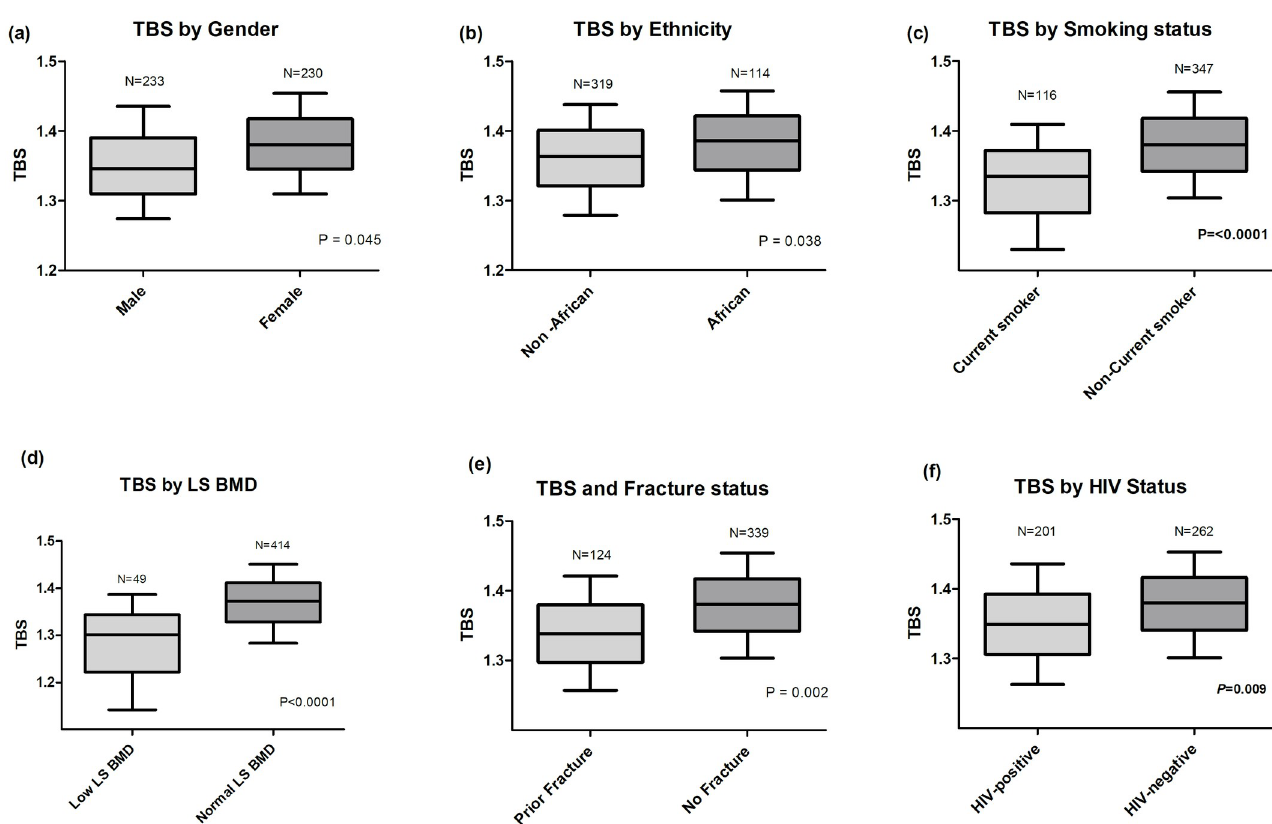
Fig 1. Median trabecular bone score according to (a) gender, (b). Ethnicity, (c). Smoking status, (d). Lumbar spine BMD, (e). Prior fracture history and (f). HIV status. TBS—Trabecular bone score, LS BMD—Lumbar spine bone mineral density, Low LS BMD defined as Z score < -2 in those 40 years old and under or a T score < -1.0 in those 40 years old or